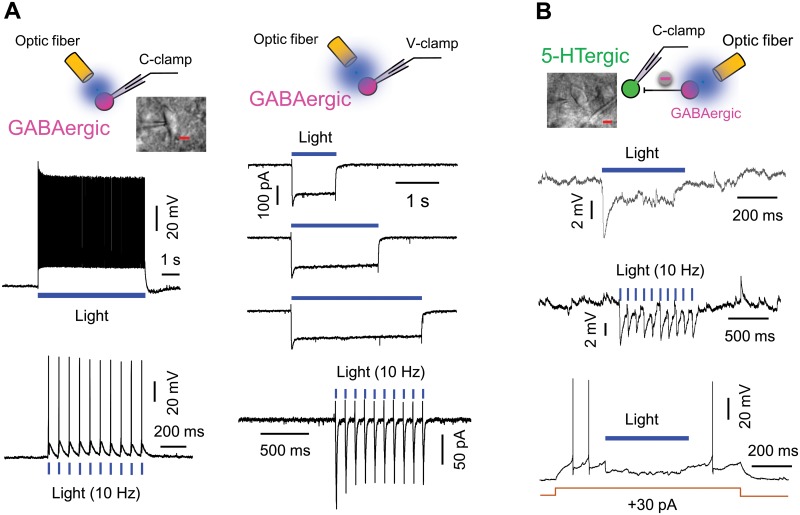
Optical stimulation excited GABAergic neurons to inhibit 5-HTergic neurons in the DRN of the ChR2 transgenic mouse (VGAT-ChR2-EYFP transgenic mouse).(A) Sample recordings of neuronal firing (left panels) and inward photocurrents (right panels) from a GABAergic neuron in response to a constant or a 10 Hz pulse (1 ms pulse width) laser light (5.5 mW, 473 nm). (B) Sample recordings showing the hyperpolarized RMP (upper and middle panels) and suppressed current-evoked firing (lower panel) in a 5-HTergic neuron by a constant or a 10 Hz pulse (1 ms pulse width) laser light (18.3 mW, 473 nm). High magnification IR/DIC image of a representative GABAergic neuron and a representative 5-HTergic neuron are shown. Scale bar: 10 μm.